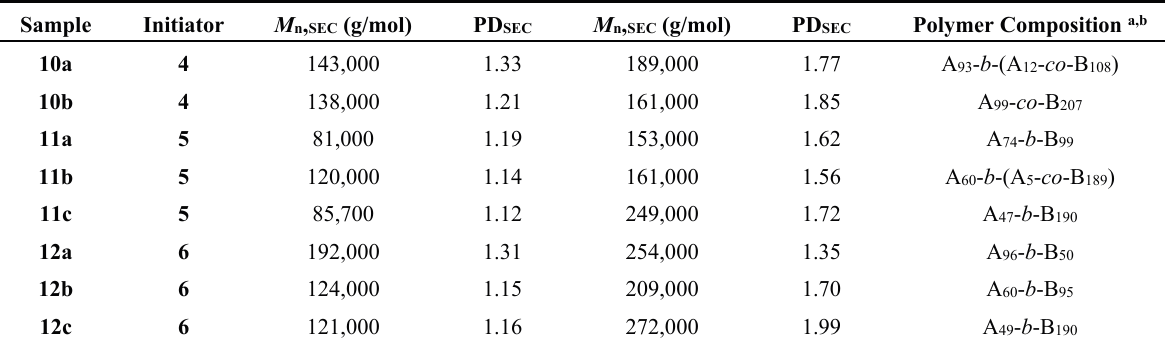
Figure 4. SEC traces of star block copolymer formation of 11c (PNIPAAm homo polymer ( blue ) and PNIPAAm-PDMAAm block copolymer ( red )). Table 3. Results of the SEC-characterization of star-like PNIPAAm- b -P(NIPAAm- co - DMAAm) diblock